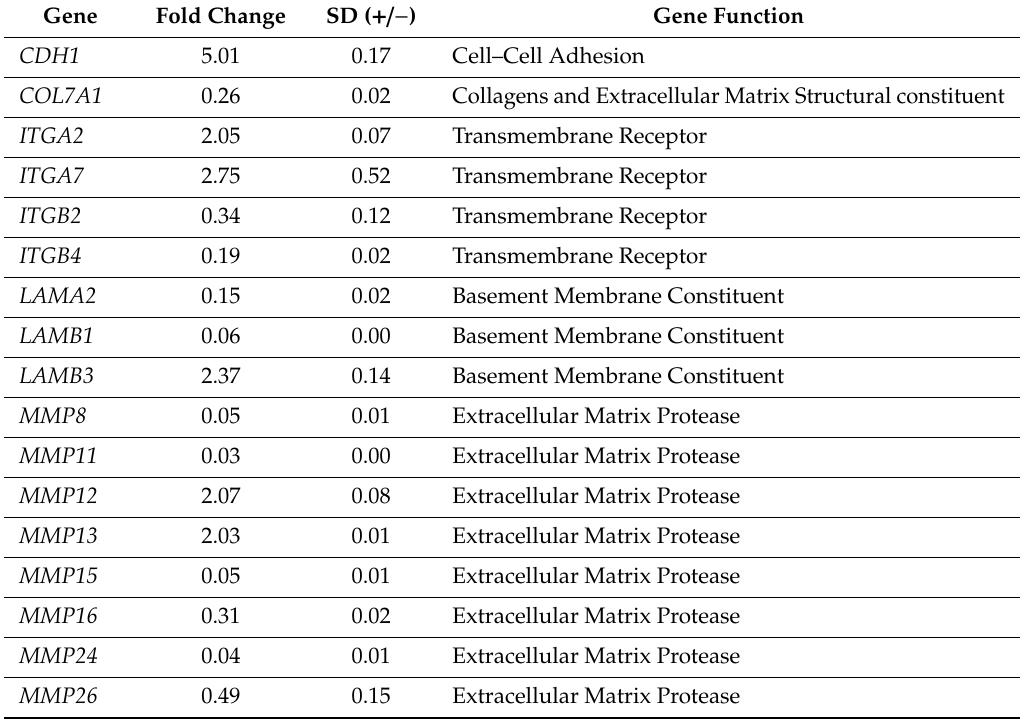
Table 2. Significant gene expression levels after 24 h treatment with cyclosporine A, as compared with untreated